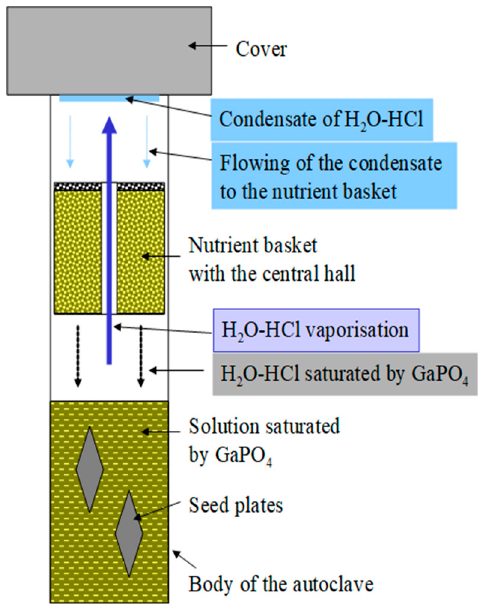
Figure 12. Principal sketch of the refluxing system in an autoclave. Mass transport in the refluxing